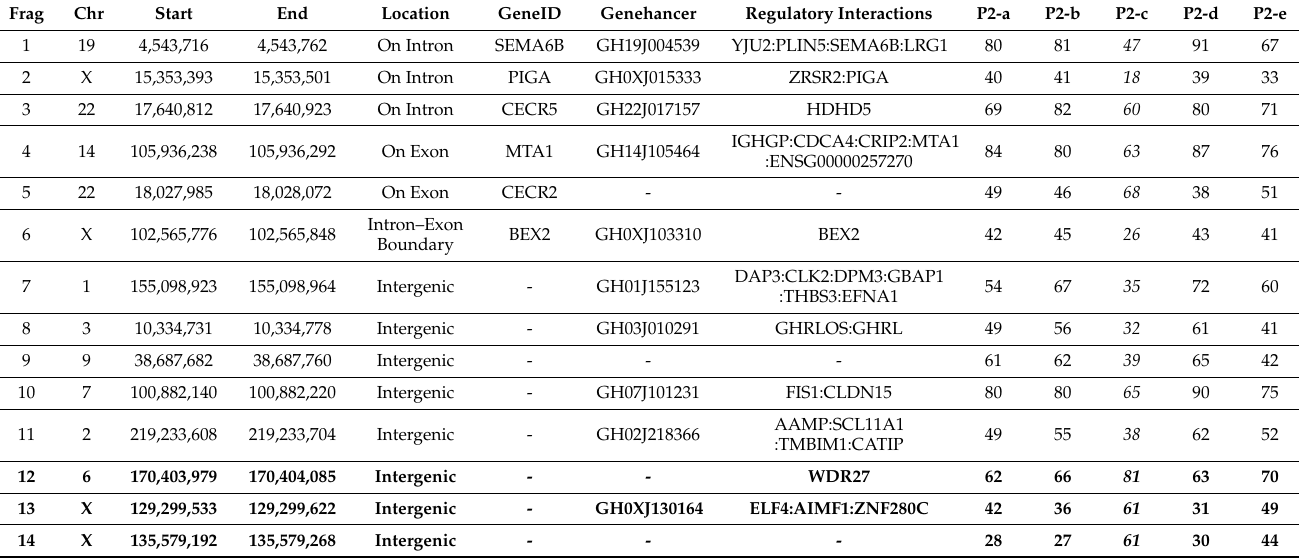
Table 2. Fragments associated with the relapse condition for P2. Fragments with a Pearson’s correlation coefficient of at least 0.9 and a mean methylation difference between the “relapse” and “recovery” time points of at least 15% are shown. The table describes the location of each fragment and the gene id if appropriate. It lists any overlapping regulatory elements (promoters/enhancers) recorded in Genehancer and the gene id associated with clusters of regulatory interaction determined using UCSC genome browser. Additionally, the table shows the methylation percent recorded for each time point (P2-a–P2-e) at each fragment with the relapse time point italicised. Fragments hypermethylated in the relapse condition are shown in bold.